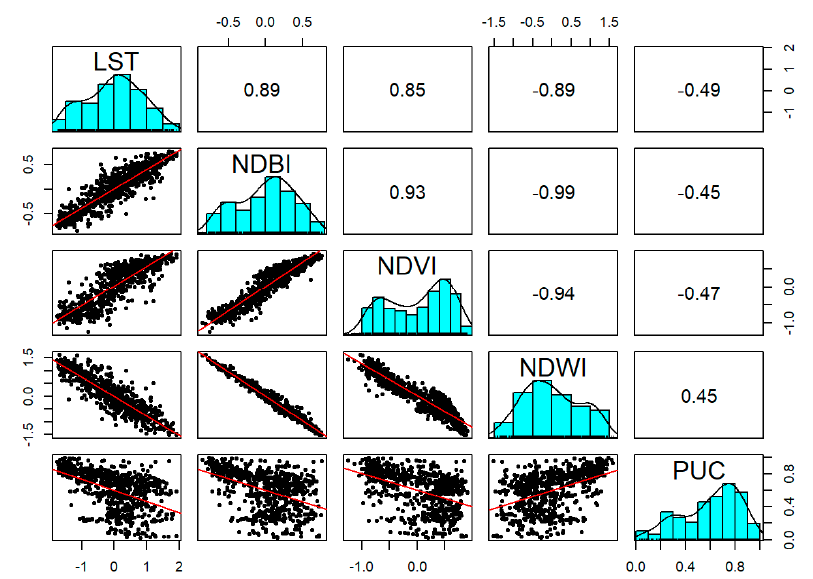
Figure 11. Histograms of the model variables (i.e., LST, NDBI, NDVI, NDWI, and PUC) in the main diagonal. Scattergrams between the model variables (below main diagonal), and the corresponding Pearson correlation (above main diagonal).